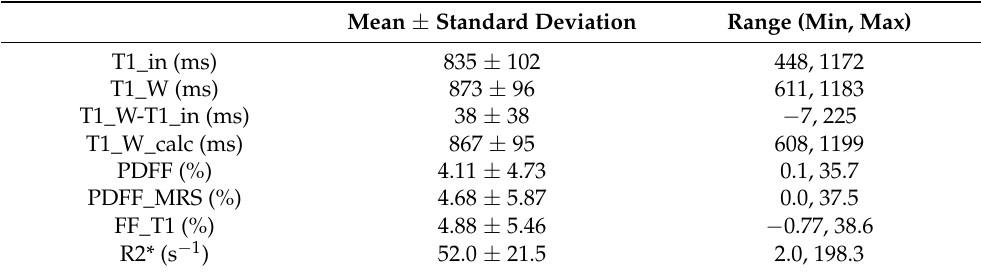
Table 1. Descriptive statistics for T1 relaxation times (T1_in, T1_W, T1_W-T1_in, T1_W_calc), liver fat